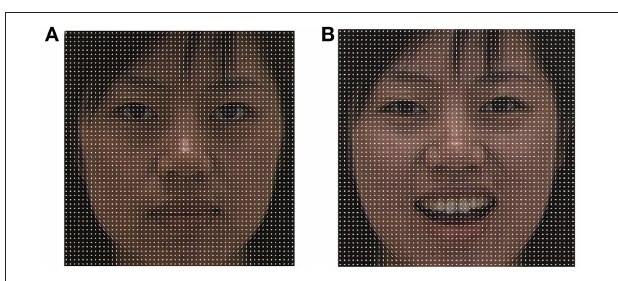
FIGURE 5 | (A) The HOG feature vector of a training image. (B) The HOG feature vector of a testing image.